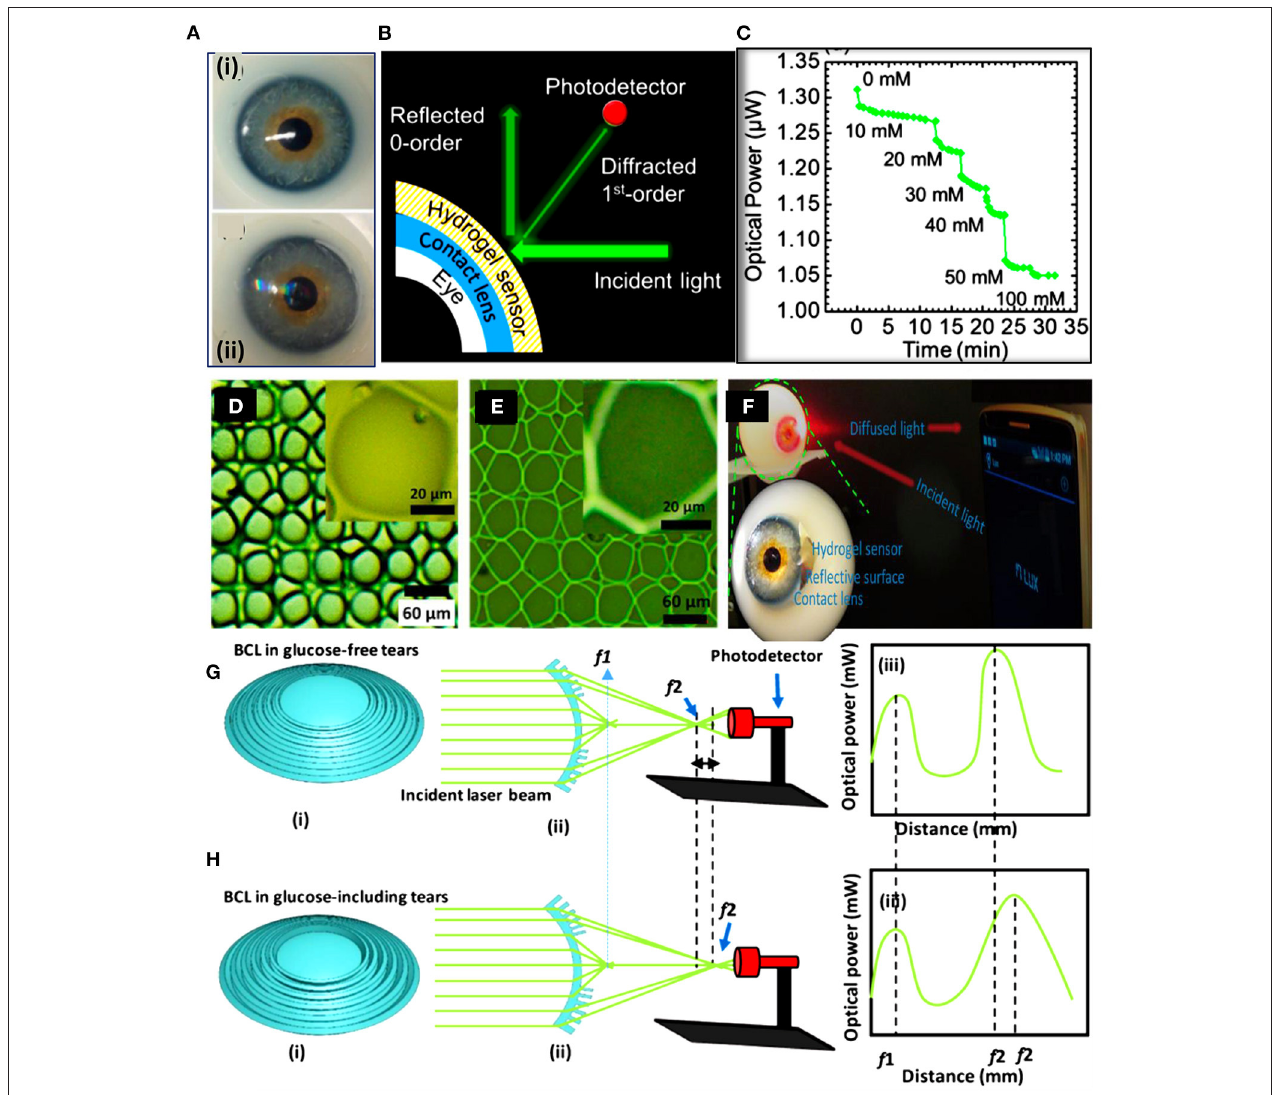
FIGURE 5 | Smart contact lenses for glucose monitoring developed based on light diffractive sensors. (A–C) A light diffraction-based glucose sensor integrated with a soft contact lens: (A) a soft commercial contact lens placed on an eye ball (i), and the commercial contact lens integrated with a 1D grating glucose sensor (ii), (B) schematic illustration of the readout methodology for the contact lens integrated with the 1D grating glucose sensor, and (C) continuous glucose detection measurements shows the reflected optical power from the contact lens vs. the glucose concentration (105). (D–F) Light diffuser-based glucose sensor: (D) optical microscope image for the master holographic light diffuser, (E) the surface of the glucose sensor imprinted with the light diffuser microstructures, and (F) photographs of the smart contact lens integrated with the light diffuser-glucose sensor and placed on an eye ball to be investigated by a smartphone as a reader (106). (G,H) Bifocal contact lenses for glucose detection: (G) schematic illustration of the bifocal contact lens in glucose-free buffer, and (H) schematic of the bifocal contact lens in glucose-complexation conditions